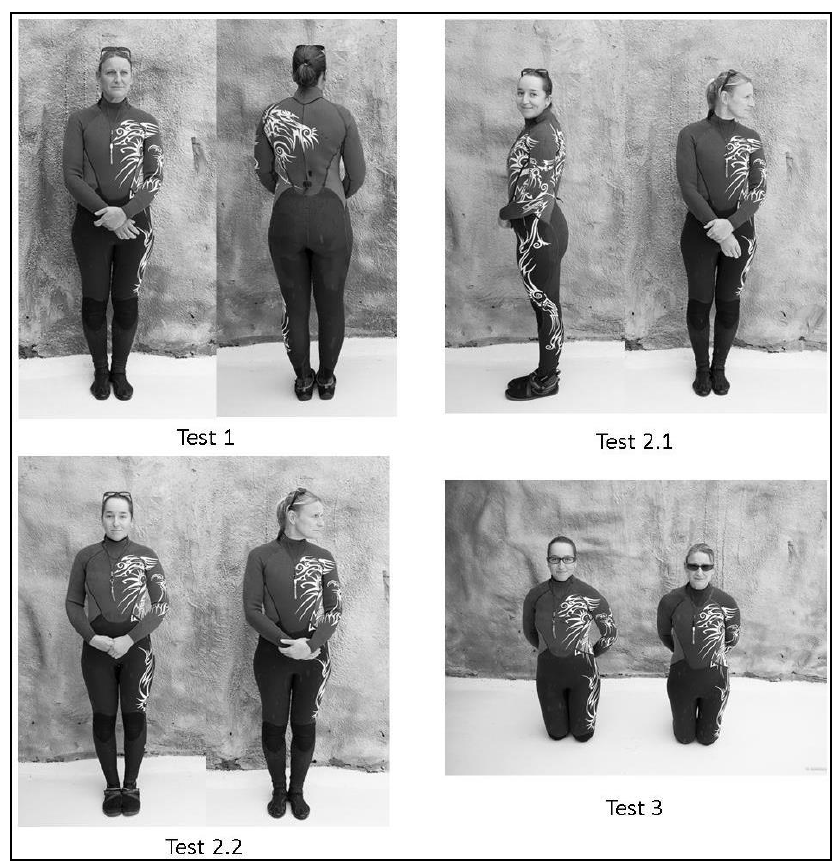
Figure 1 . Pictures of the different postures used in this study. For each picture, the attentive caretaker is on the left. Picture 1 represents the body orientation, pictures 2.1 and 2.2, the head orientation and picture 3, the eye visibility. Shaping phase 1. During this phase the trainers desensitized the subjects to the new procedures. By facing and looking at the sea lion, caretakers B and C were both showing the “attentive state.”